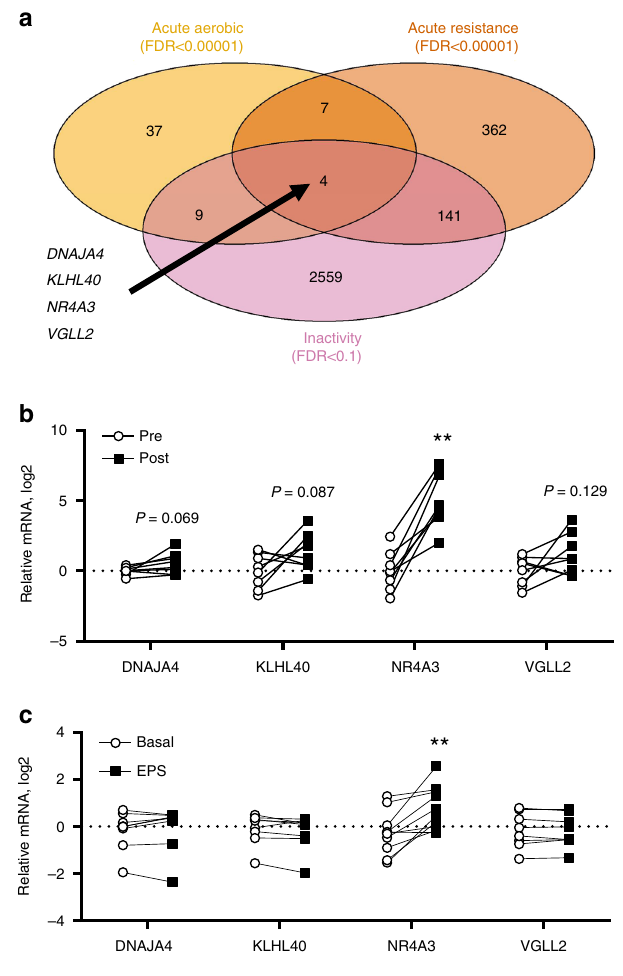
Fig. 4 DNAJA4 , KLHL40 , NR4A3 , and VGLL2 respond to exercise and inactivity. a Genes signi fi cantly modi fi ed by acute aerobic and resistance exercise and inactivity were overlapped in a Venn Diagram. b DNAJA4 , KLHL40 , NR4A3 , and VGLL2 were validated in an independent cohort of pre- and post-acute aerobic exercise. Individual paired t -tests vs pre, n = 8 biologically independent volunteers, ** p < 0.01. c DNAJA4 , NR4A3 , KLHL40 , and VGLL2 gene expression following electrical pulse stimulation in primary human myotubes. Individual paired t -tests vs basal, n = 8 biologically independent primary cells from different donors, ** p